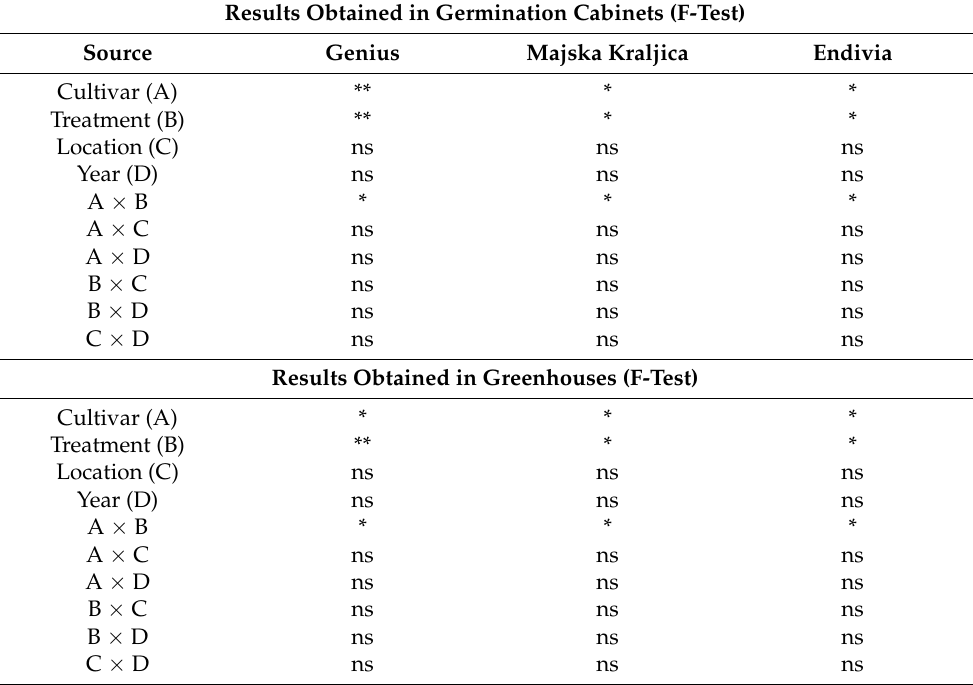
Table 4. Factors on germination and the seedling growth after treatments applied to lettuce cultivars. Results Obtained in Germination Cabinets